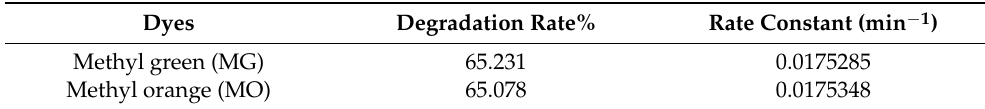
Table 1. Degradation rates (%) and rate constants for photocatalytic degradation of dyes using biogenic CuO NPs.